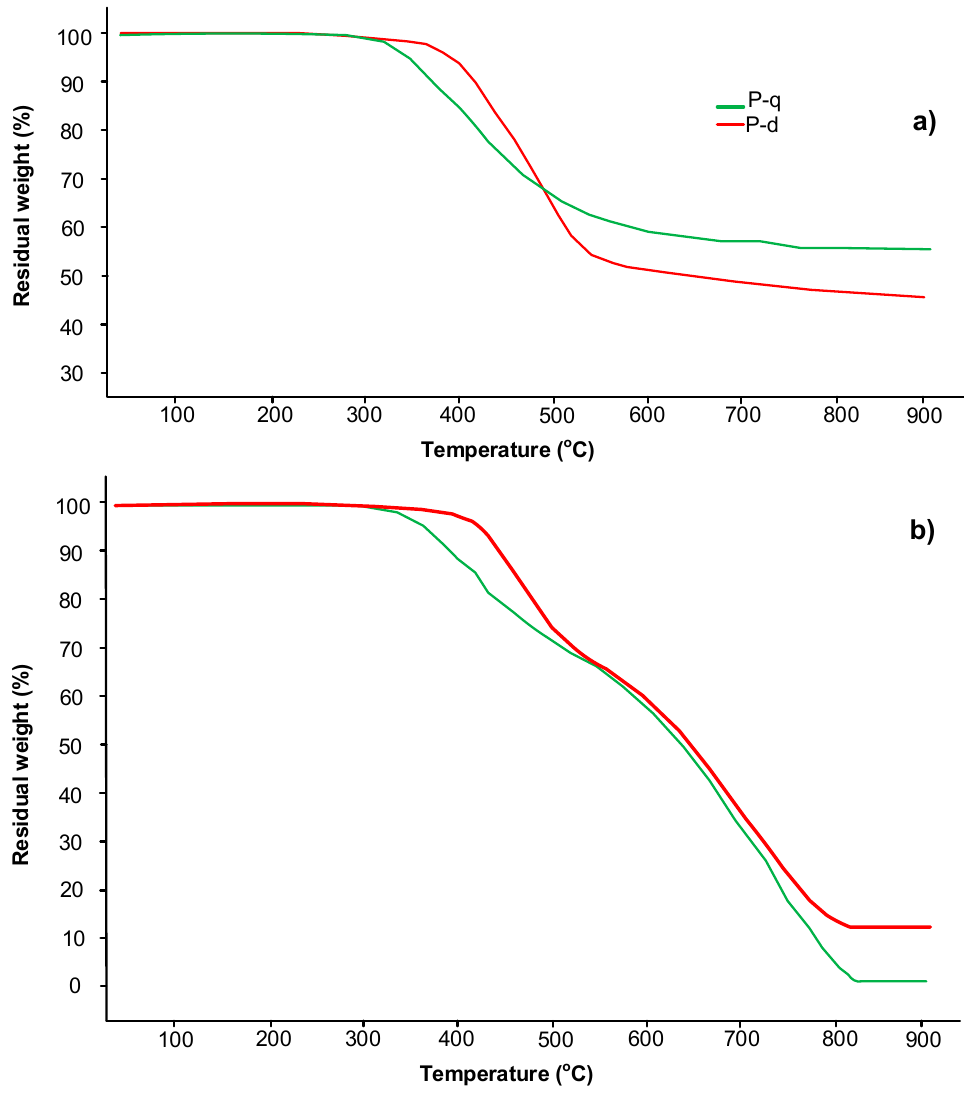
Figure 13. TGA curves of polyP-d and polyP-q: ( a ) in the argon; ( b ) in the air atmosphere. The structures formed during thermal destruction of polyP-q are described below (Table 7). Table 7. The results of TG-MS analysis of volatile products of polyP-q in air and inert atmosphere. №